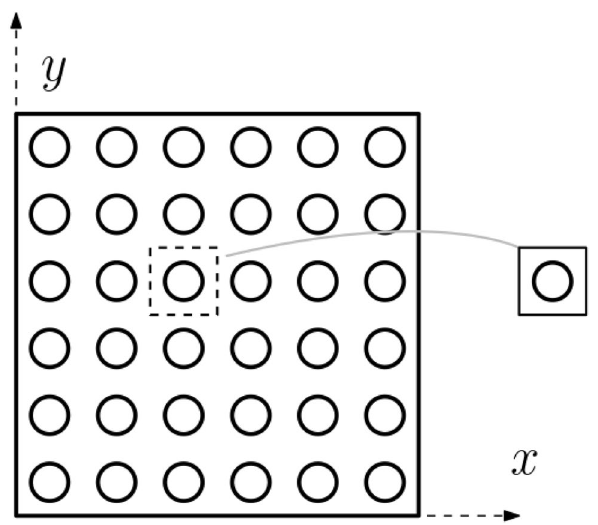
Fig. 6 An example of a material containing several inclusions. Due to the periodicity a unit cell is easily defined (right hand side of